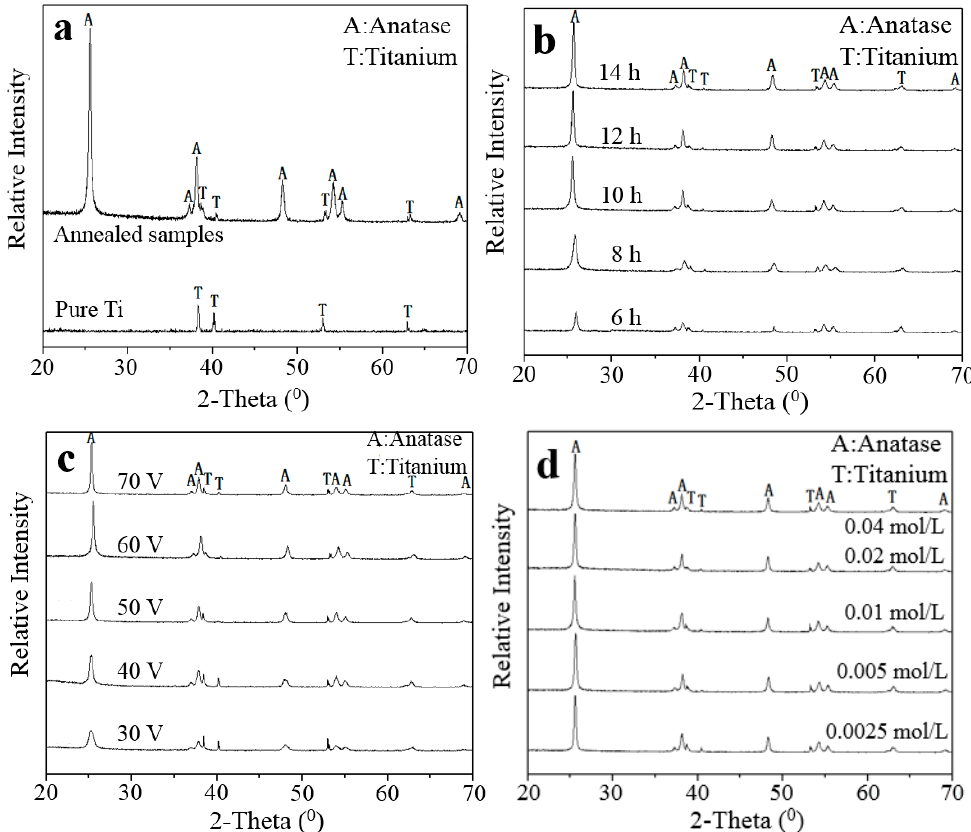
Figure 2. XRD patterns of ( a ) Ti, annealed samples, ( b ) and ( c ) TiO 2 prepared at different times (6–14 h) and voltages (30–70 V), ( d ) different Gd concentrations (0.0025–0.04 mol/L).